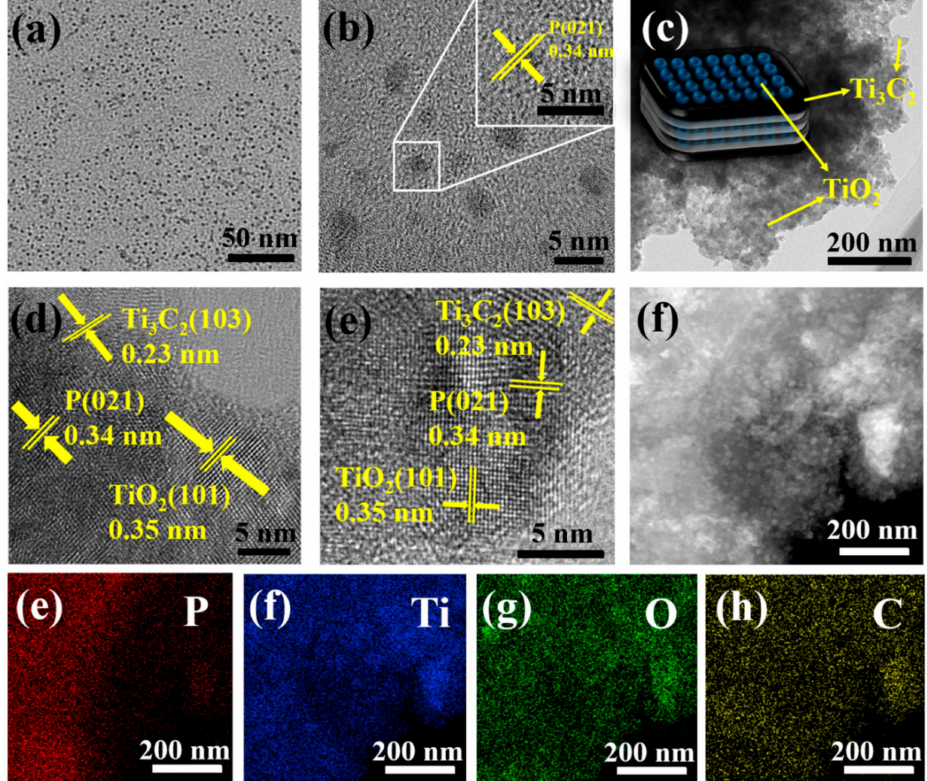
Figure 5. ( a , b ) HRTEM images of BPQDs; ( c – e ) HRTEM images of BTTC-120 sample; and ( f – h ) element mappings of P, Ti, O, and C of